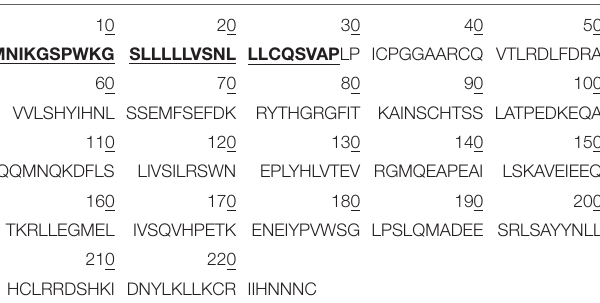
HCLRRDSHKI DNYLKLLKCR